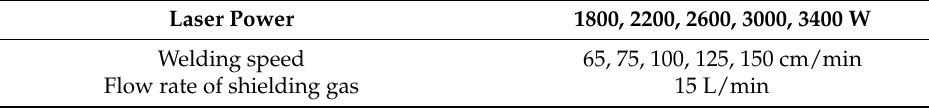
Figure 2. Welding process: ( a ) schematic illustration; ( b ) field experiment. Table 2. Process parameters used in the welding